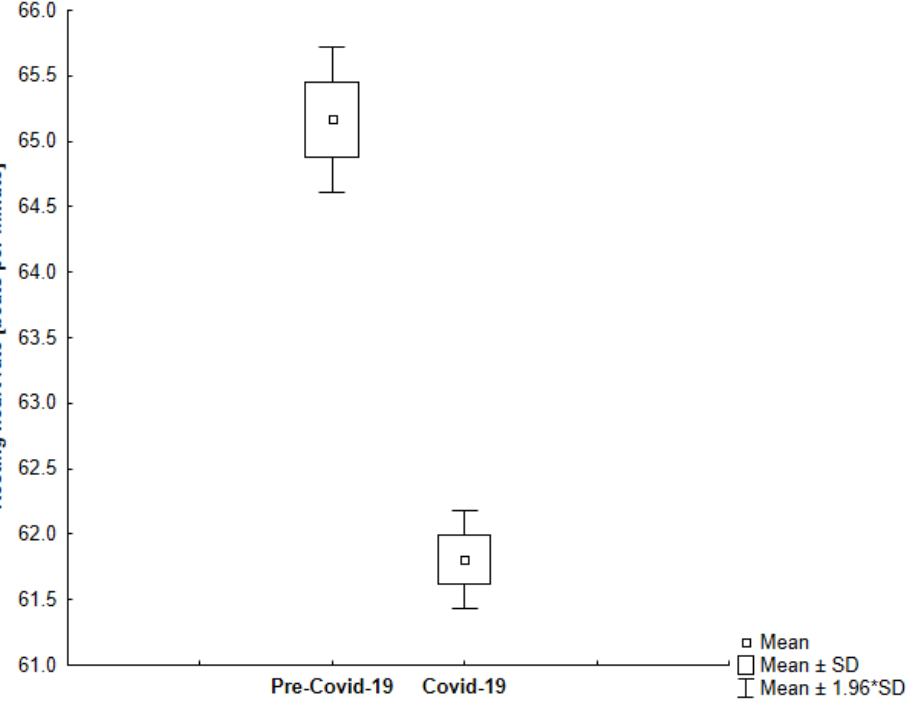
Figure 7. The comparison of the average resting heart rate in the analyzed periods among younger participants ( p < 0.001).